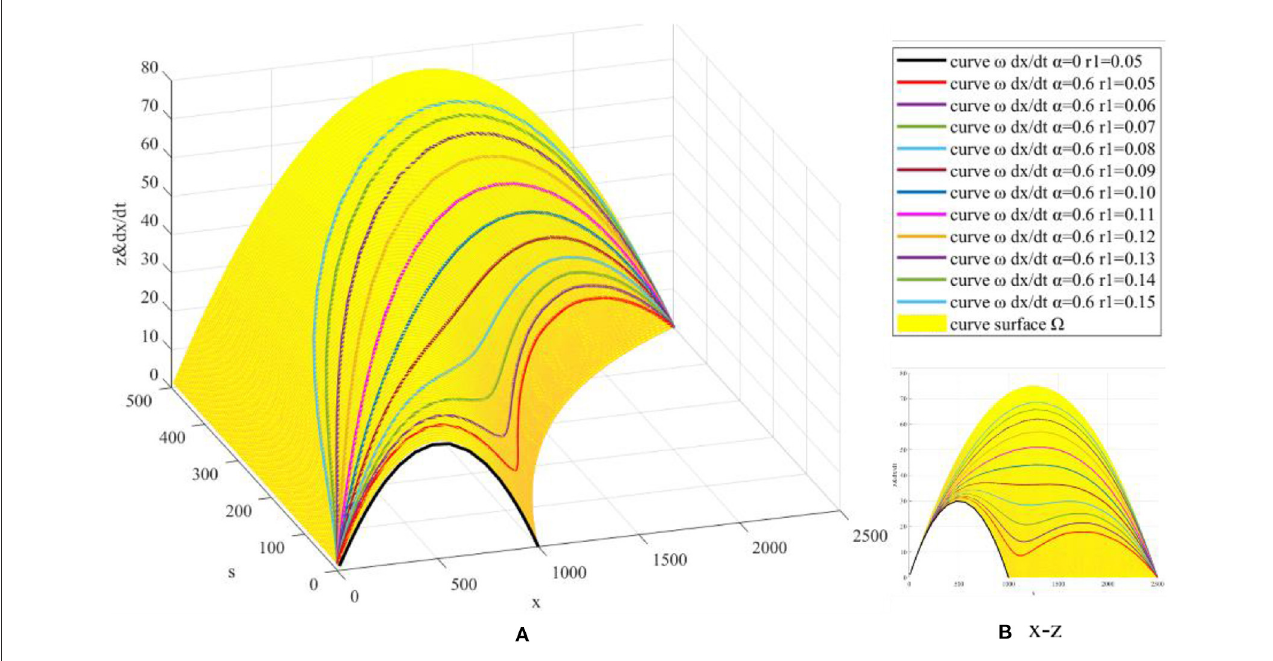
FIGURE6 Simulation based on r 1